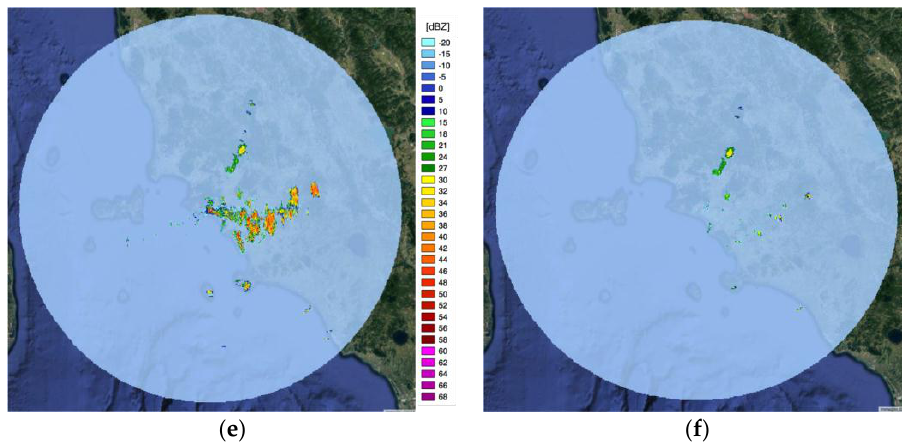
Figure 5. PPI radar scans at an elevation of 1.5° for 23 May 2016, 09:00 UTC, without ( left panels) and with ( right panels) the application of the sea and ground clutter removal algorithms for the radars of Livorno ( a , b ); Elba ( c , d ); and Castiglione della Pescaia ( e , f ).